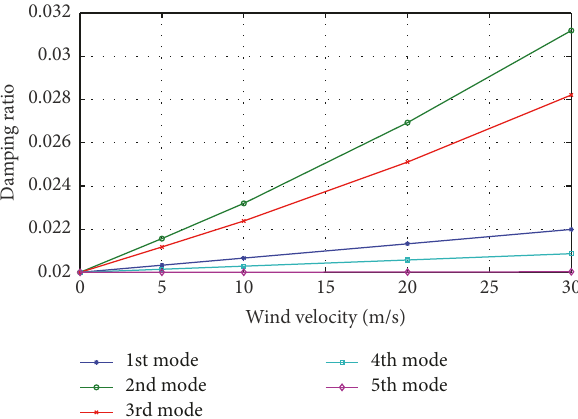
Figure 17: Structural damping ratio according to wind velocity.